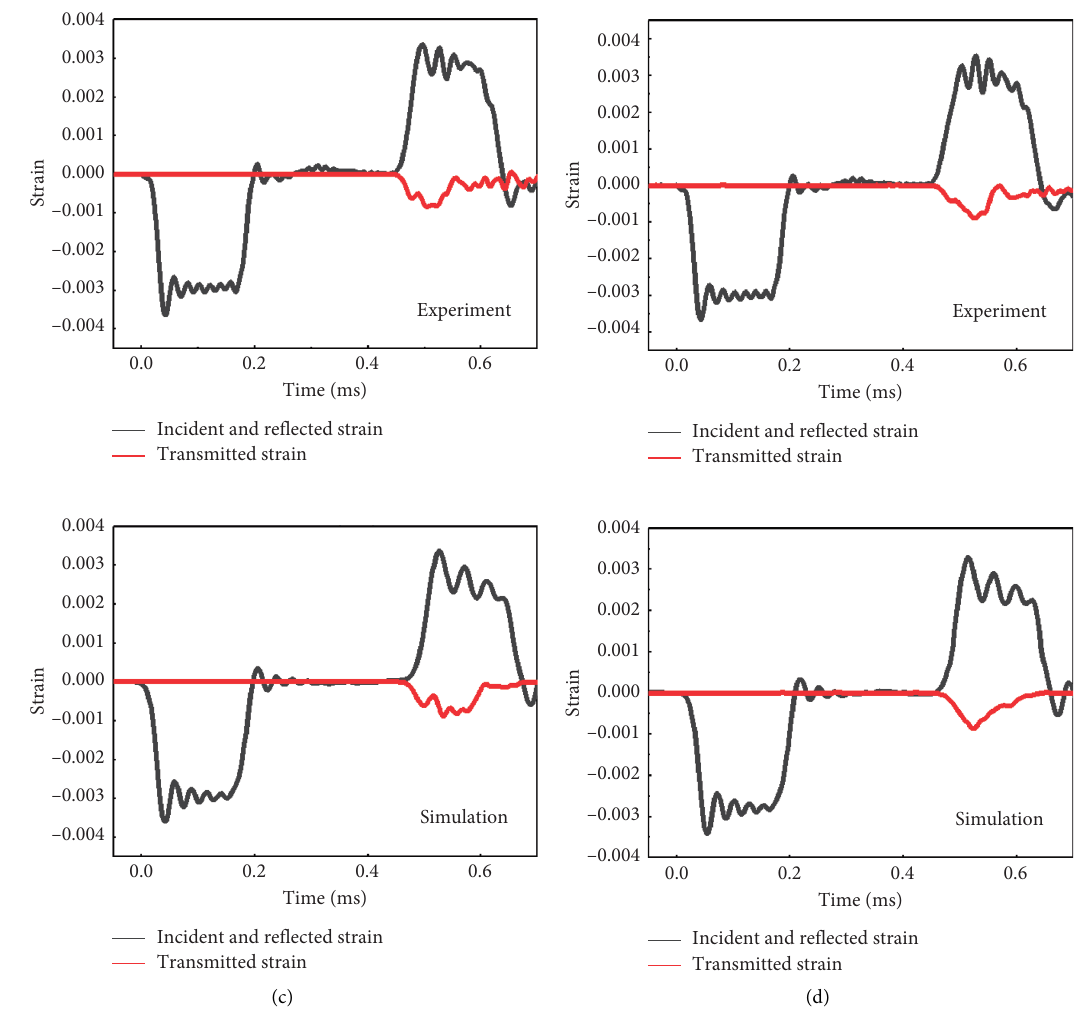
Figure 3: Experimental signals and simulation signals: (a) Structure I; (b) Structure II; (c) Structure III; (d) Structure IV.